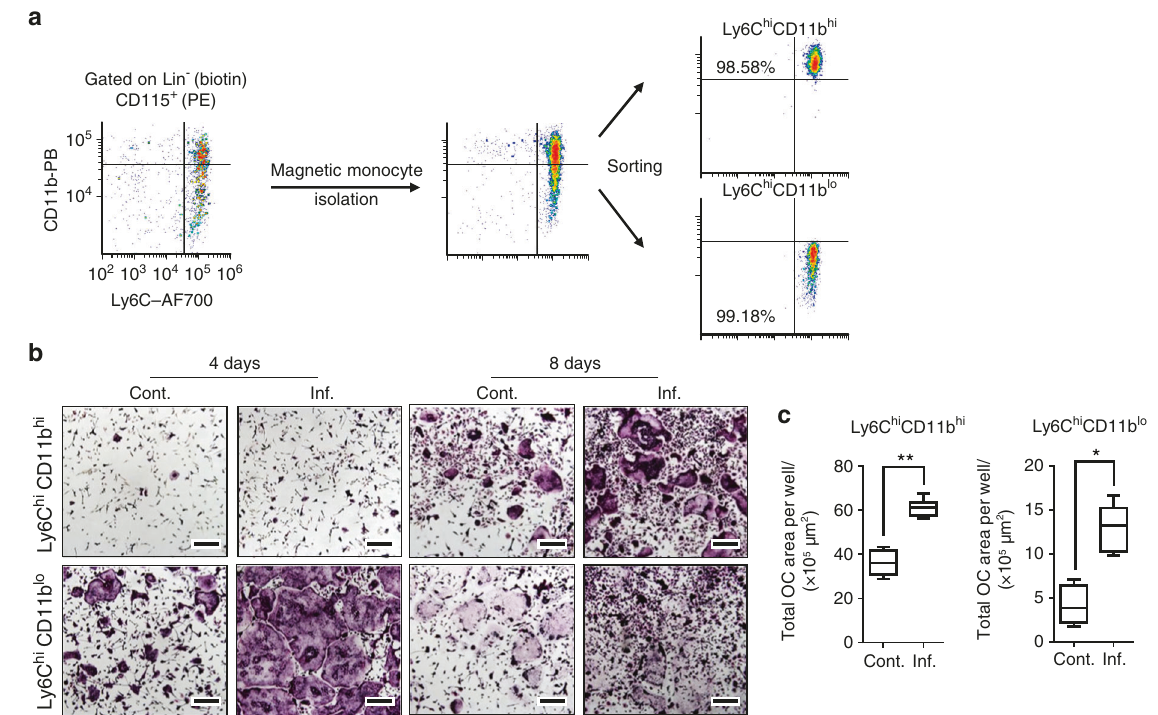
Fig. 2 Ly6ChiCD11bhi and Ly6ChiCD11blo cells give rise to OCs in vitro. a The isolation and sorting strategy for Ly6C hi CD11b hi and Ly6C hi CD11b lo cells is presented, and the purity was ≥ 98% in all samples. b Sorted Ly6C hi CD11b hi or Ly6C hi CD11b lo cells (10 4 ) from the BM of control and in fl amed mice were cultured with osteoclast differentiation medium for 4 and 8 days. Multinucleated TRAP-stained OCs appeared in Ly6C hi CD11b lo cultures after 4 days and in Ly6C hi CD11b hi cultures after 8 days (bar: 200 µm). c Area quantitation of OCs derived from Ly6C hi CD11b lo cells after 4 days and from Ly6C hi CD11b hi cells after 8 days in culture. b , c Control n = 5, in fl amed n = 5, for each cell population; representative results for 5 independent experiments (Mann – Whitney test). Line: median, box: 25th – 75th percentile, whiskers: range. * P < 0.05, ** P <